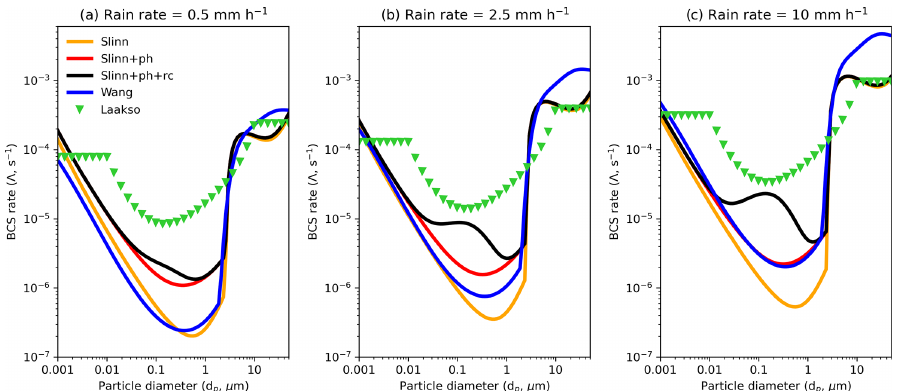
Figure 3. BCS rate ( (cid:51) , Eq. 2) as a function of aerosol diameter for five BCS models (Sect. 2) and for rain rates representing (a) drizzle, (b) moderate rain, and (c) heavy